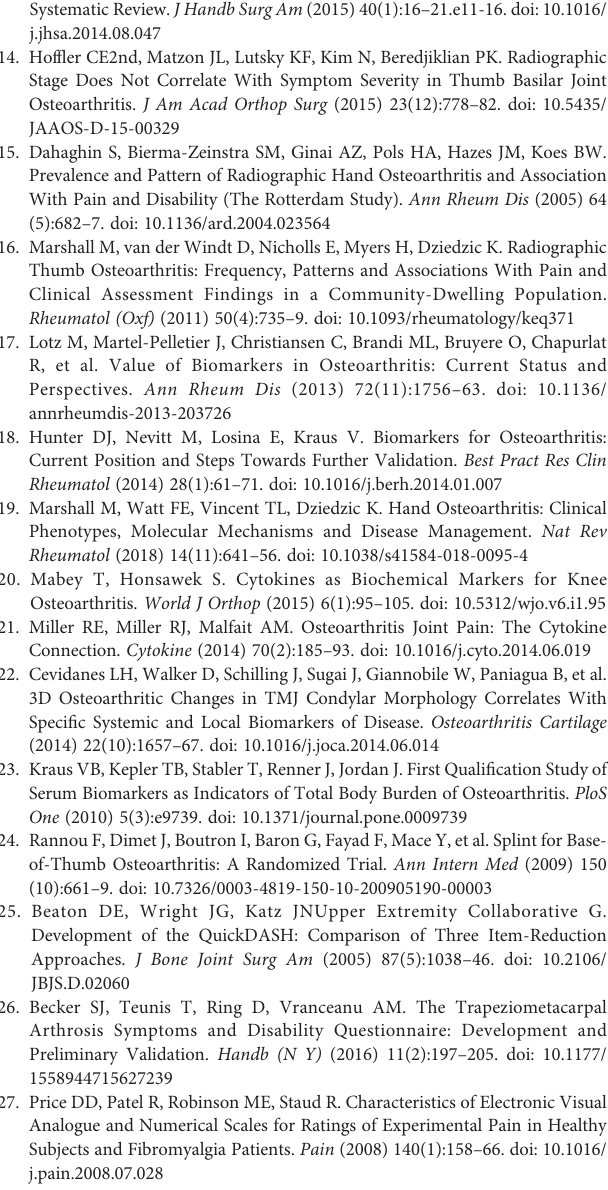
Supplementary Table 4 | Associations between clinical outcomes and cytokine expression over time. After adjusting for age, sex, BMI and painful joint count there were few signi fi cant associations between change in cytokine expression over time and clinical outcome, (n= 44 surgical baseline, n=20-22 6 months, n=16-17 one- Supplementary Table 5 | Roles and OA context of cytokines which differentiate patient subgroups. The traditional role of each cytokine or chemokine, as well as its associations within OA literature are described. Supplementary Table 6 | Baseline Data. Baseline data for surgical and non- surgical patients, including clinical characteristics, PROM, functional scores and baseline cytokine measurements (pg/ml) are